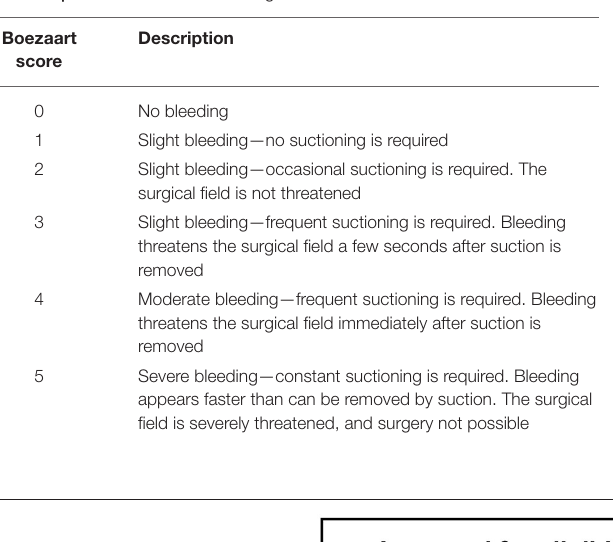
TABLE 1 | Boezaart score for the surgical field.